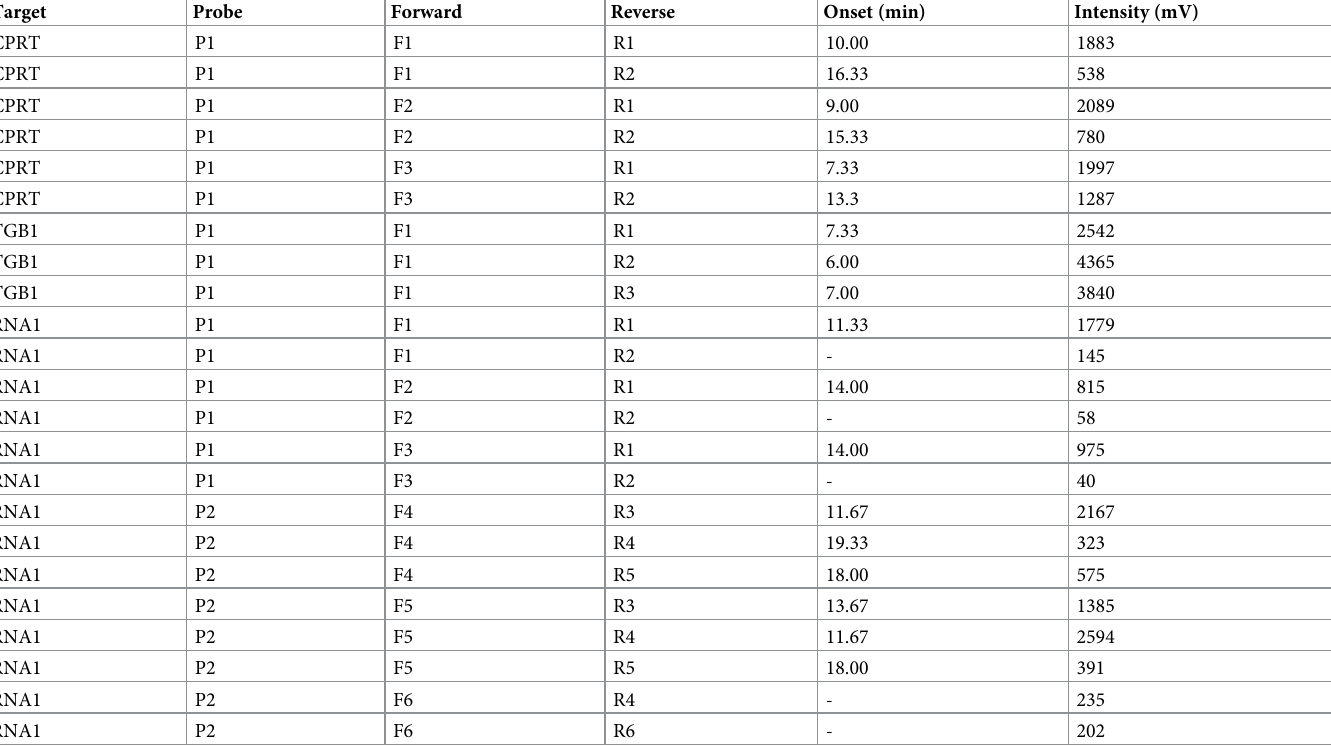
Table 2. RPA XRT screening of oligos for potato mop-top virus (PMTV) detection using RNA from a tuber. Sample onset time and intensity are provided as averages for two replicates of each combination. Sample onset time was determined by evaluating change in fluorescence intensity over time, set arbitrarily at 60 RFU/min. Intensity is an evaluation of the fluorescence output of a given oligo combination. Combinations that failed to amplify PMTV resulted in a “-” for no onset and intensities below 200